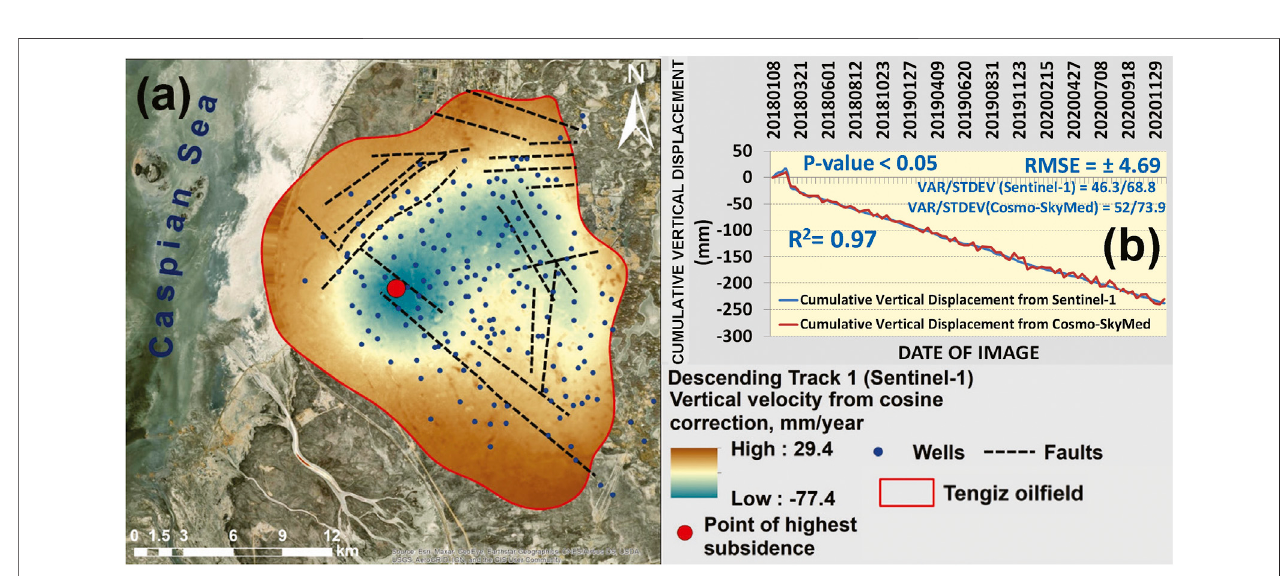
FIGURE 9 | Vertical displacement velocity derived from the Sentinel-1 and COSMO-SkyMed satellite images for: (A) pro fi le 1, (B) pro fi le two; regression analysis between vertical displacement velocities derived from the Sentinel-1 and COSMO-SkyMed satellite images for: (C) pro fi le 1, (D) pro fi le two.